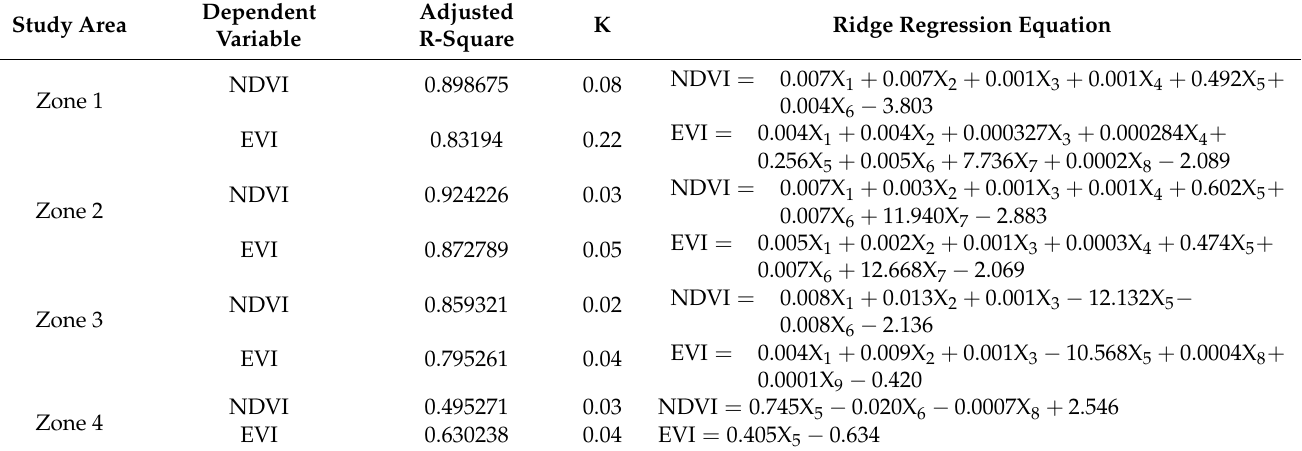
Table 10. Ridge Regression results.